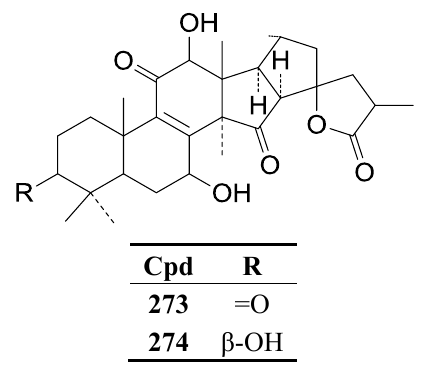
Figure 28. Structures of compounds 273 – 274 .